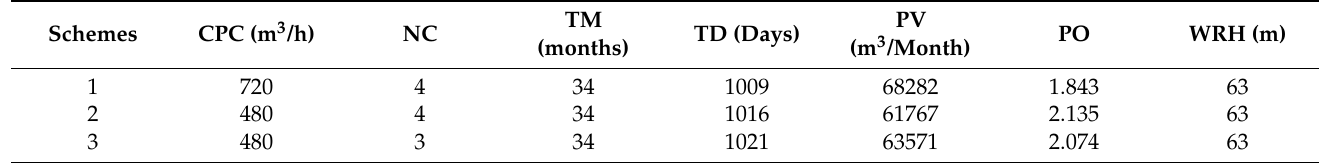
Table 8. Values of the progress attributes for the arch dam construction.